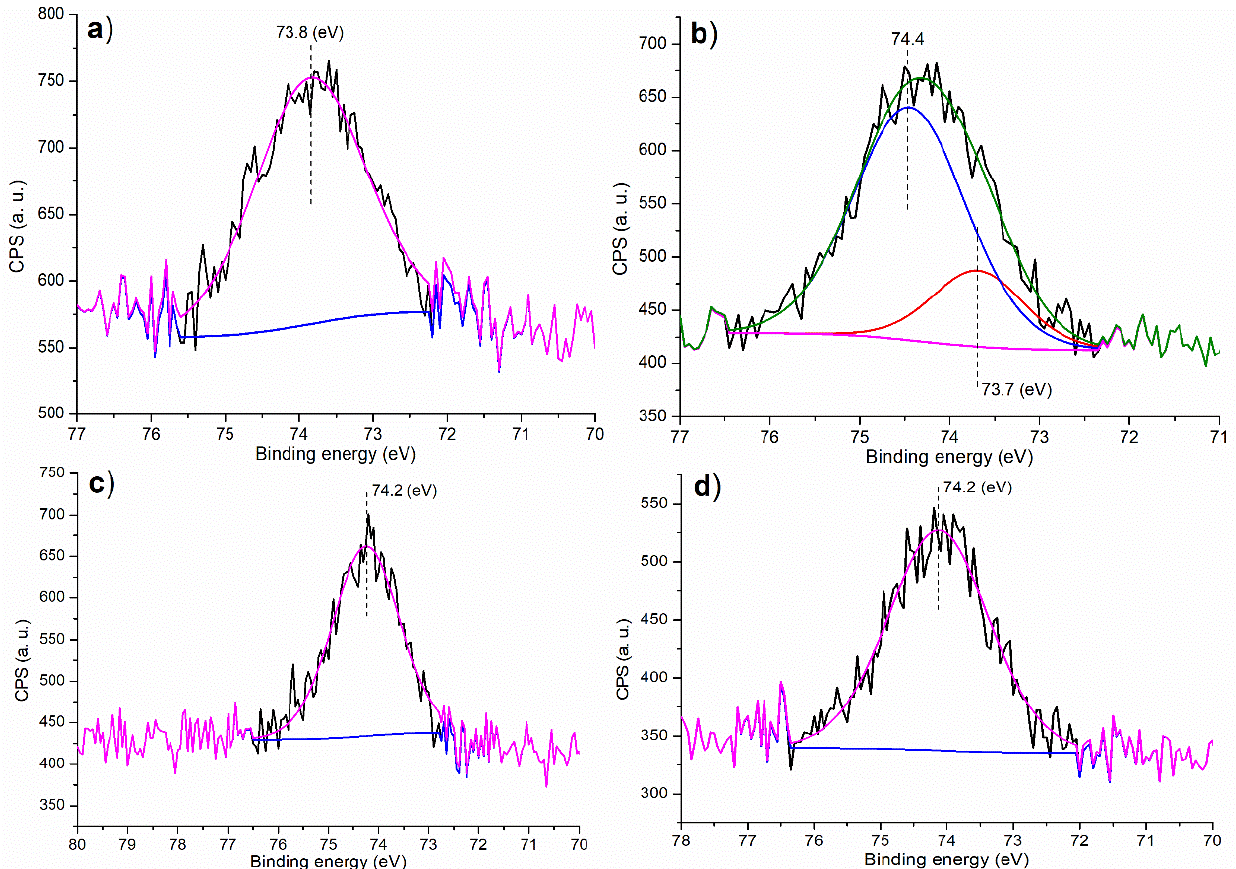
Figure 3. XPS measurements of the Al 2p region: ( a ) Cement, ( b ) sample 2, ( c ) sample 7, and ( d ) sample 10.